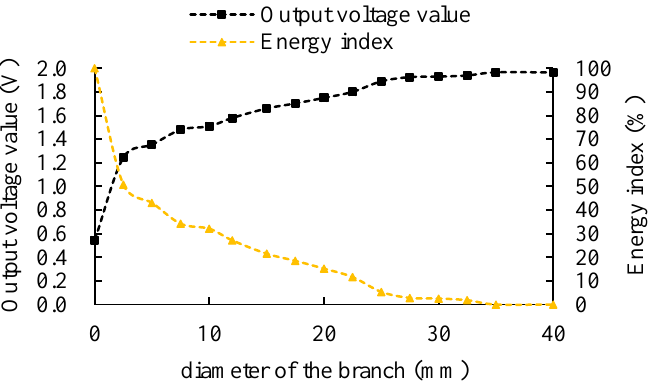
Figure 11. The output voltage and energy index variation of the impedance measurement circuit.